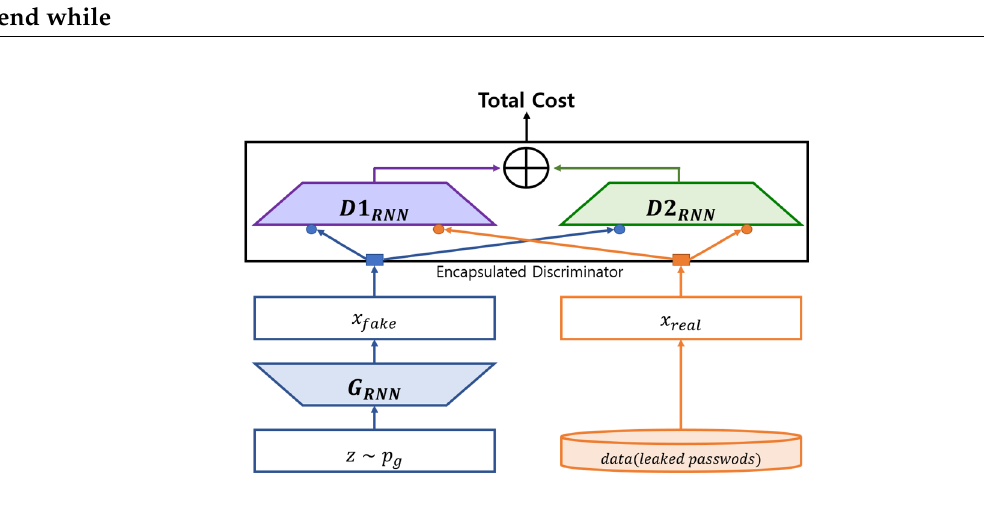
Figure 2. rPassD2CGAN block